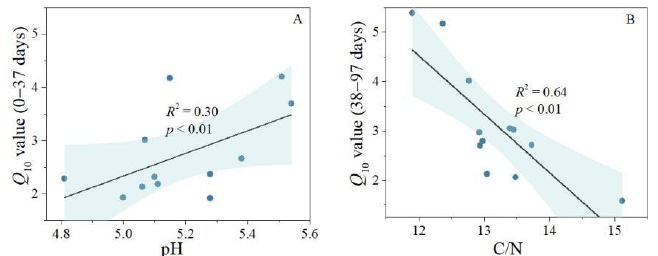
Figure 4. Relationships between the Q 10 without litter and pH ( A ) during the 0 – 37 days incubation period. Relationships between the Q 10 and C/N ( B ) during the 38 – 97 days incubation period. Forests 2022 , 13 , x FOR PEER REVIEW